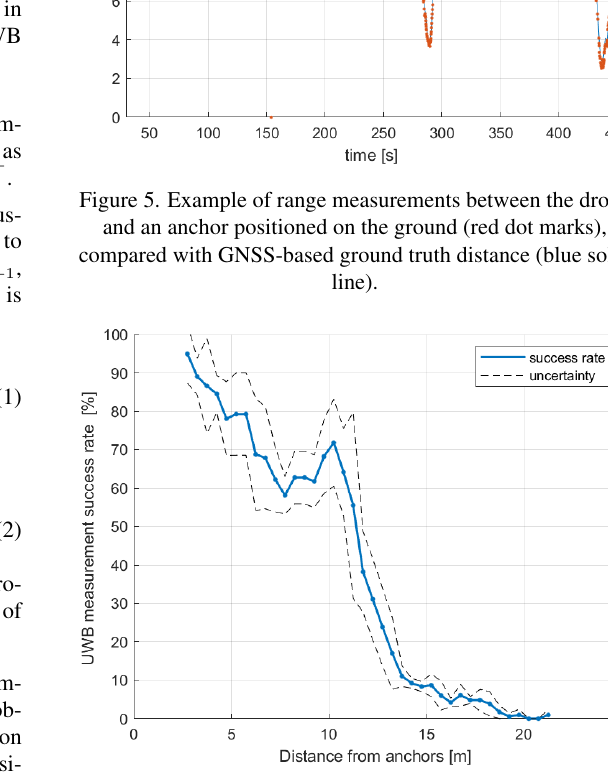
Figure 6. UWB measurement success rate varying the drone distance with respect to the